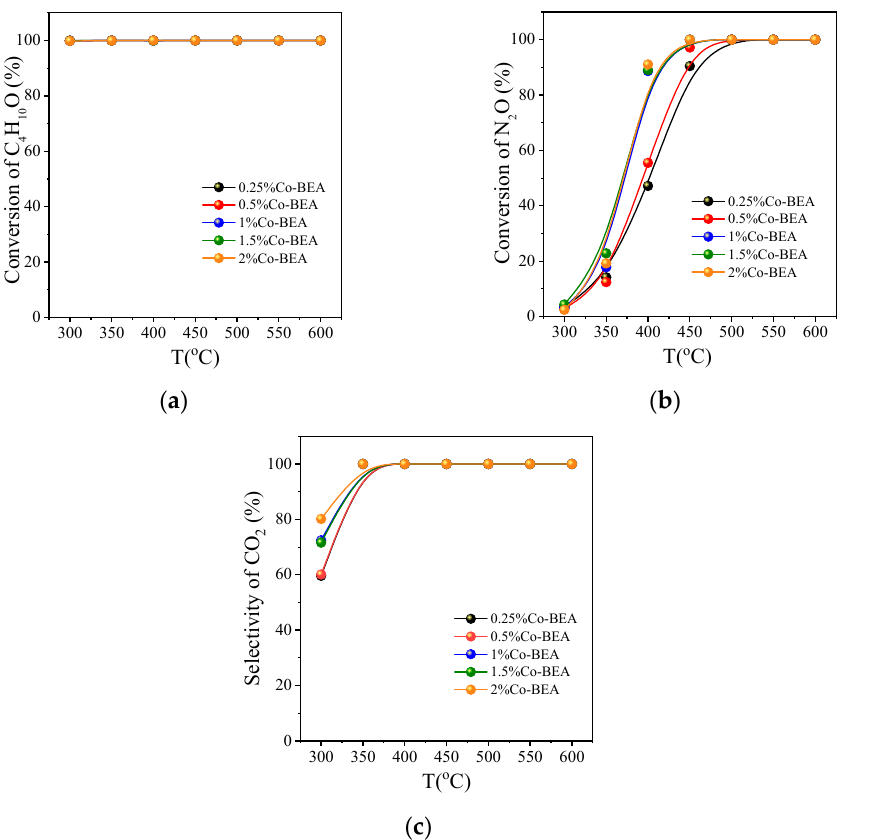
Figure 9. Catalytic oxidation of C 4 H 10 O on Co-BEA with different concentrations: ( a ) the conversion of C 4 H 10 O; ( b ) the conversion of N 2 O; ( c ) the selectivity of CO 2 ; reaction conditions: GHSV = 8000 h − 1 , C 4 H 10 O:N 2 O:O 2 :He = 0.2:7:5:87.8.